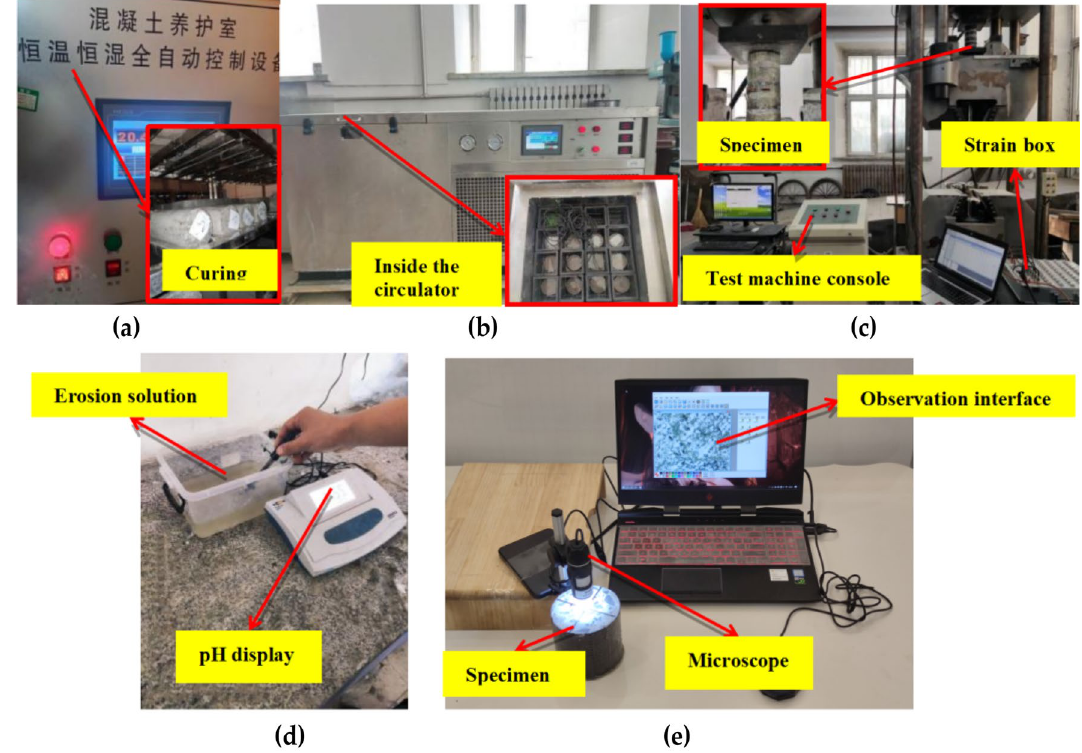
Figure 3. Test method: (a) constant temperature and humidity equipment; (b) freeze–thaw cycle machine; (c) universal test press; (d) pH tester; (e) microscopic